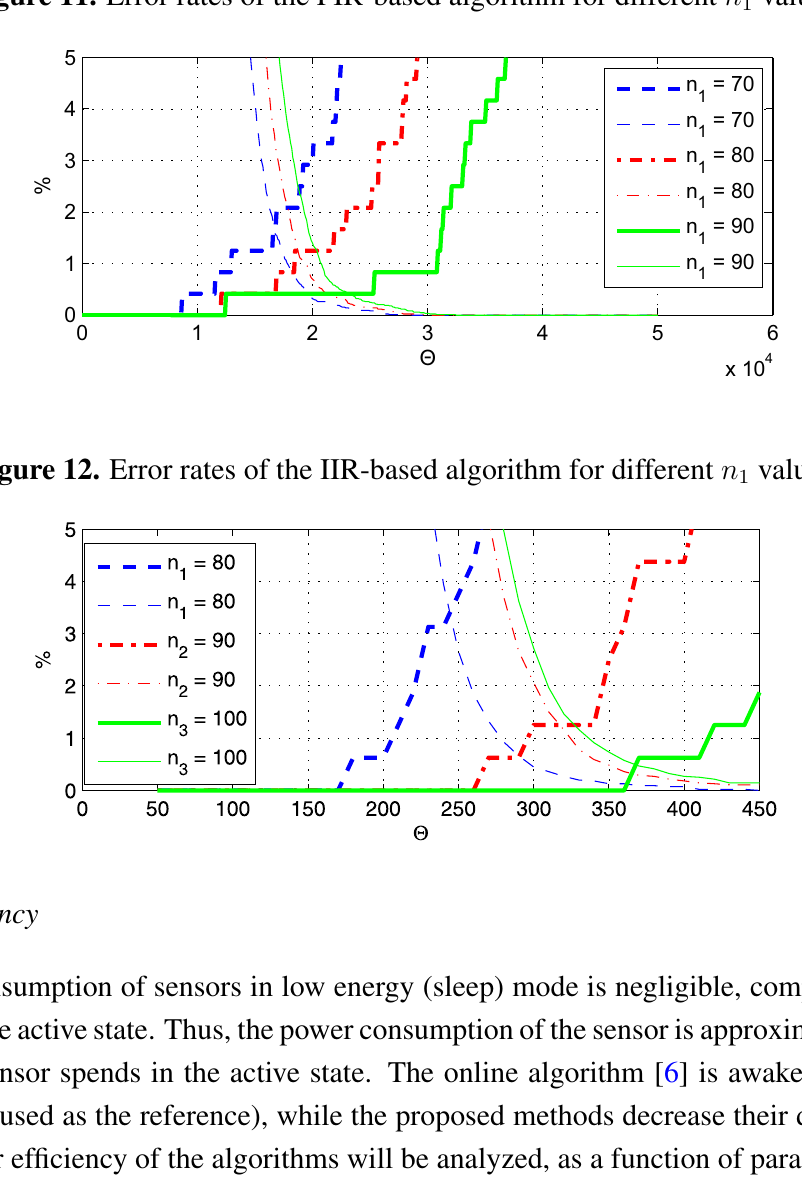
Figure 11. Error rates of the FIR-based algorithm for different n